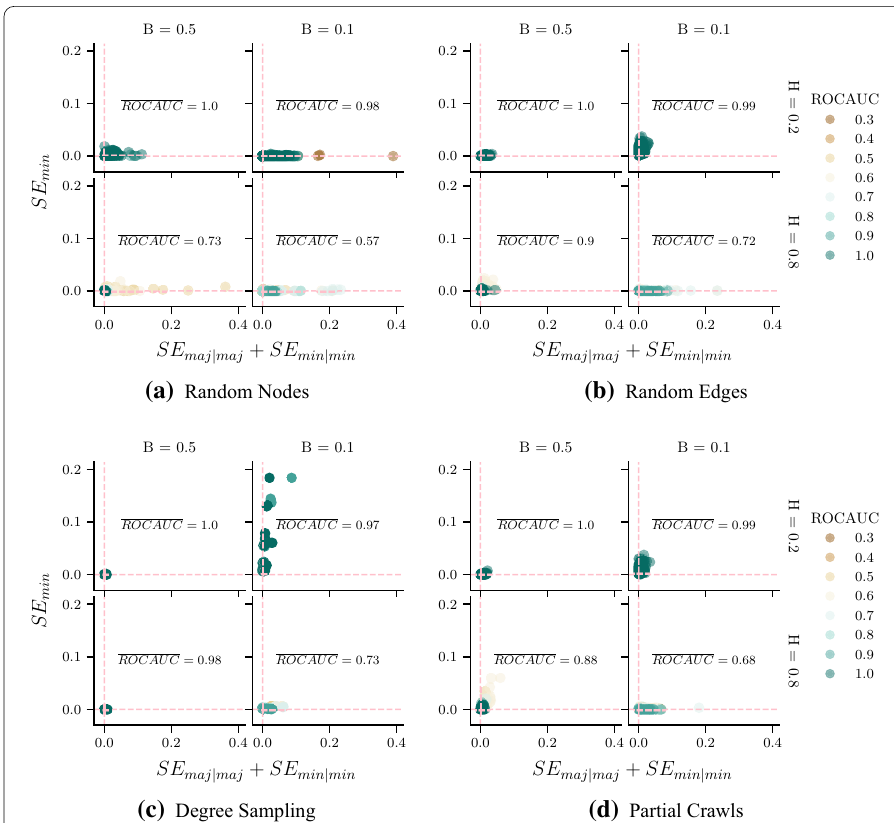
Fig. 4 RQ2: Parameter estimation and overall performance on small samples. These are the squared estimation errors of class priors (y‑axis) and conditional probabilities (x‑axis) with their respective overall performance (colors) on small samples ( pseeds ≤ 30% ) using different sampling techniques: a random nodes, b random edges, c degree sampling, and d partial crawls. Class balance and homophily values are shown as columns B and rows H , respectively. Mean ROCAUC scores per network type (B,H) are shown as ROCAUC . Conditional probabilities obtained by partial crawls ( SE maj | maj + SE min | min < 0.18 ) are the most accurate, followed by random edges, degree sampling and random nodes. However, the most accurate class priors are obtained by random nodes ( SE min < 0.02 ), followed by random edges, partial crawls, and degree rank. In terms of performance, on average degree sampling achieves the highest ROCAUC followed by random edges, partial crawls, and random nodes. Surprisingly, perfect estimates ( (cid:31) SE = SE min + SE maj | maj + SE min | min ≈ 0 ) do not guarantee perfect performance ( ROCAUC ≈ 1.0 ), and vice